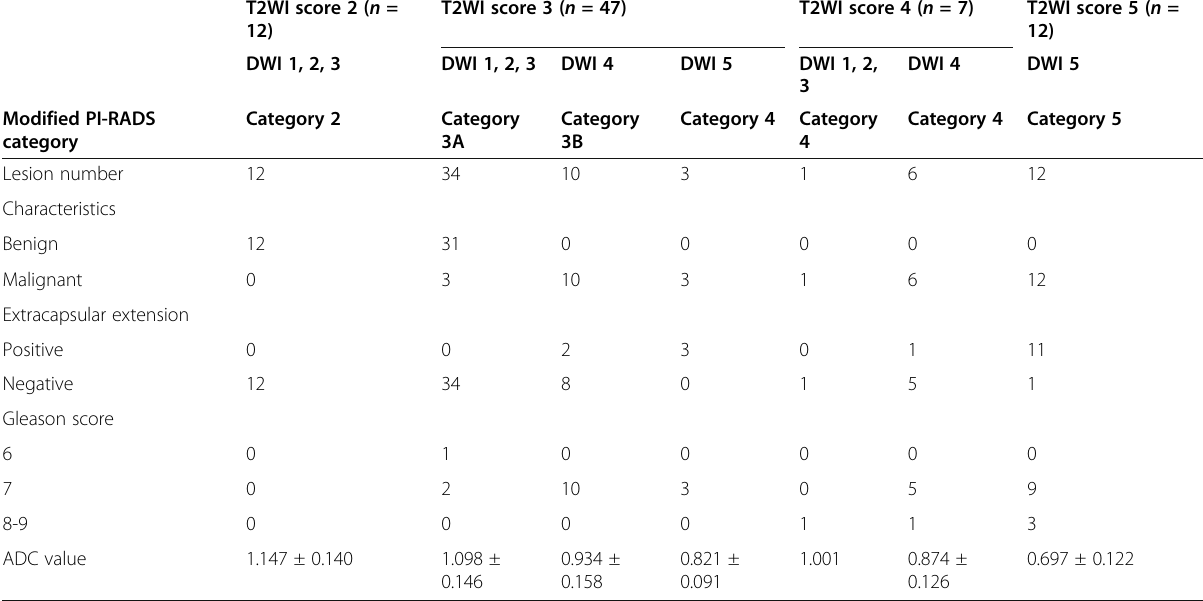
Table 3 Comparison of clinicopathologic characteristics and ADC value between T2WI scores in transition zone prostate